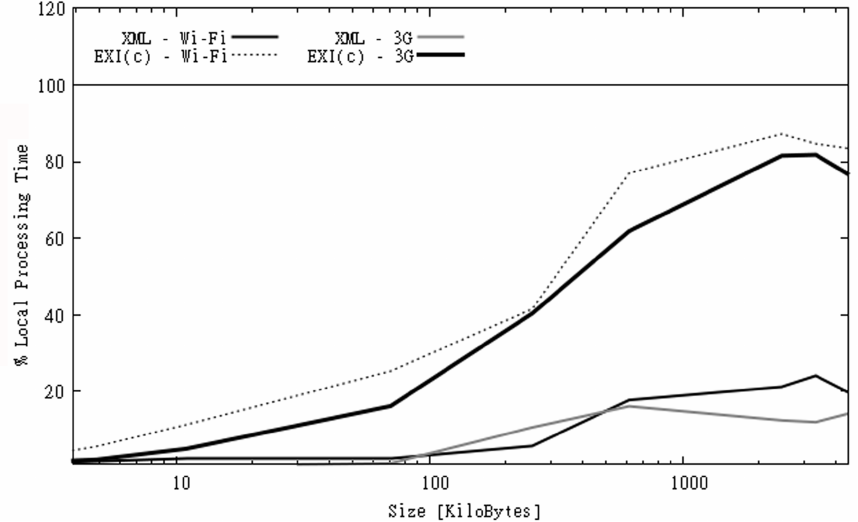
Figure 9. Percentage of time spent on parsing/decompression and communication for SGS2 smarthphone (OBS